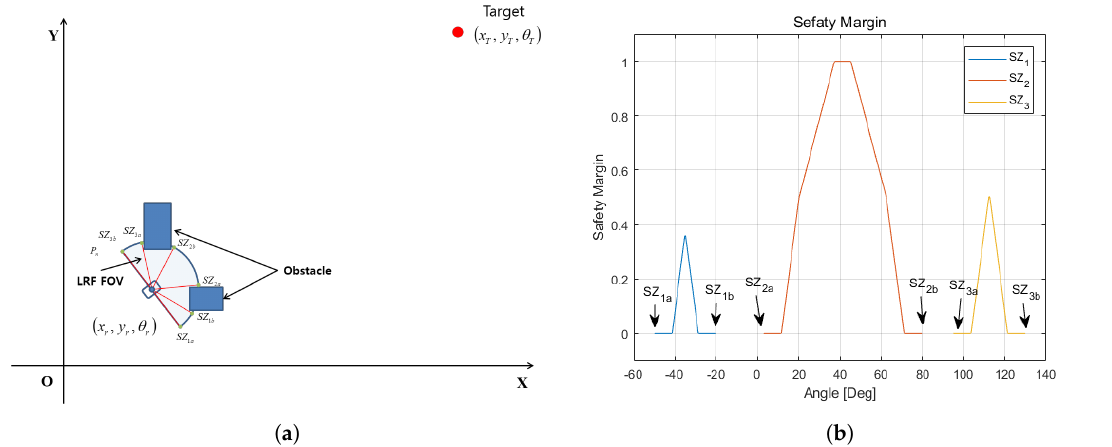
Figure 3. Safety margin under obstacles: ( a ) Description of safety zone ( b ) Function of safety